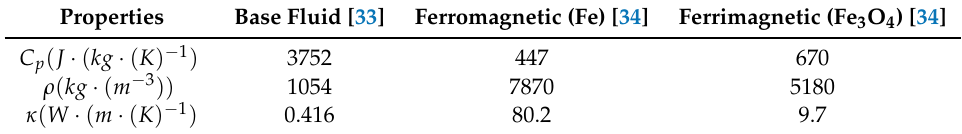
Table 1. Physical properties of the base fluid (60% water + 40% ethylene glycol) and nano-particles.